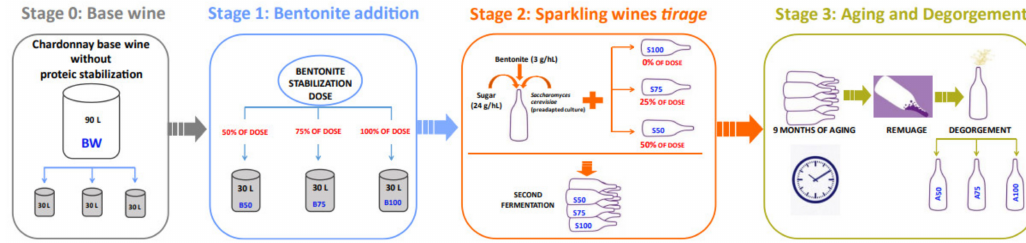
Figure 1. Schedule of the production process and the samples